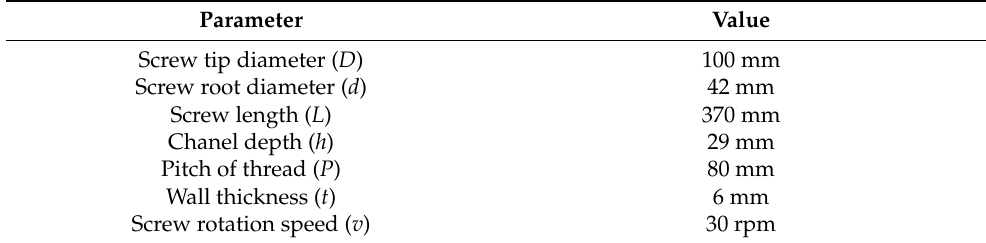
Table 5. The specific parameters of the single-screw